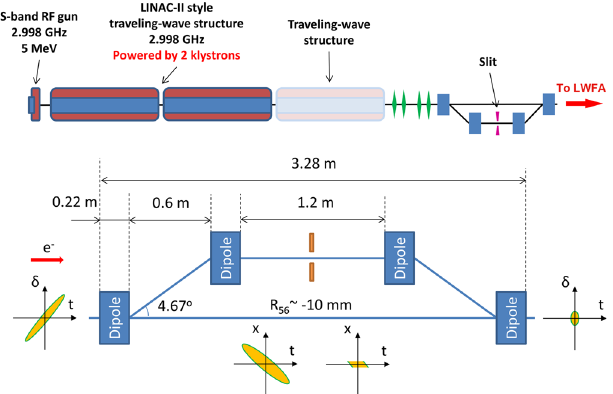
FIG. 1. Layout of the SINBAD linac (up) and schematic of the magnetic chicane with a slit (down). The blue rectangles represent dipole magnets while the green diamonds are quadru- pole